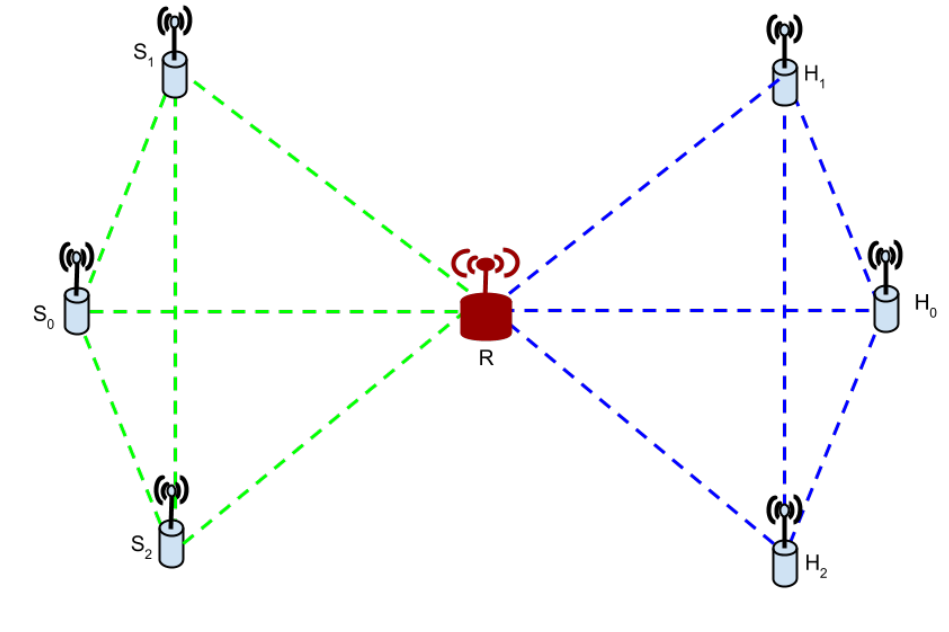
Figure 1. Collision domains in a wireless